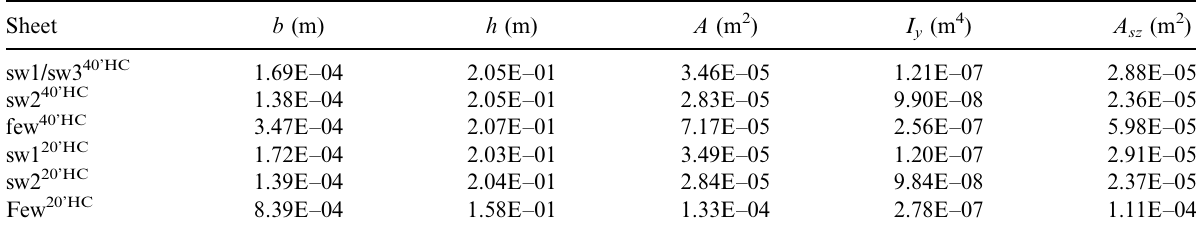
Table 5. Geometrical properties of strengthening bars Sheet